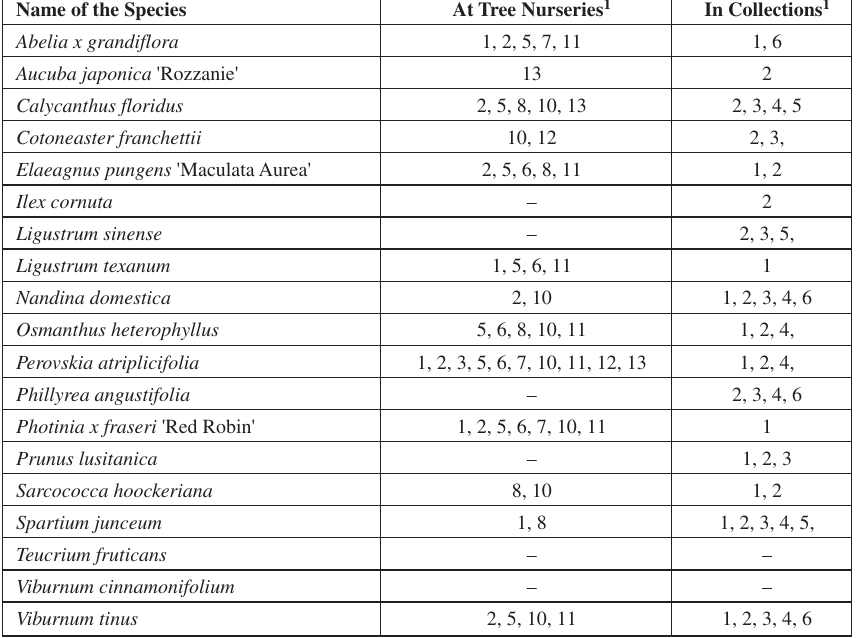
Table 1: The occurrence of the examined species at tree nurseries and